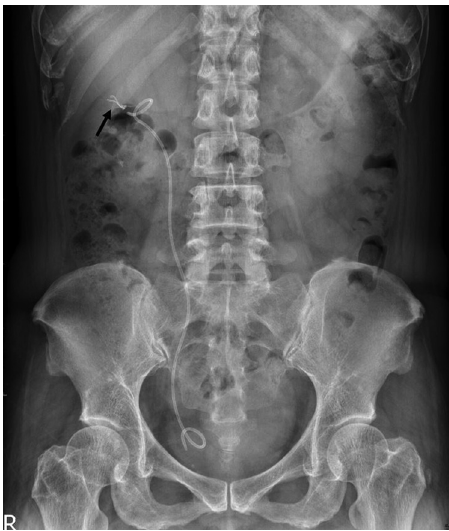
Figure 1: Post - PCND follow - up KUB show a new radiopaque lesion ( arrow ) in right kidney area.